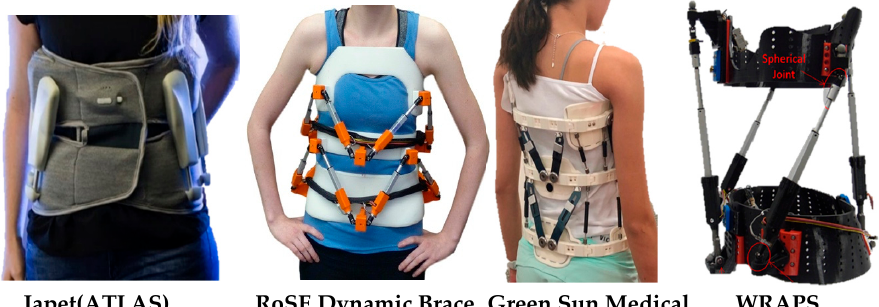
Figure 3. Smart rehabilitation orthoses for the spinal column.